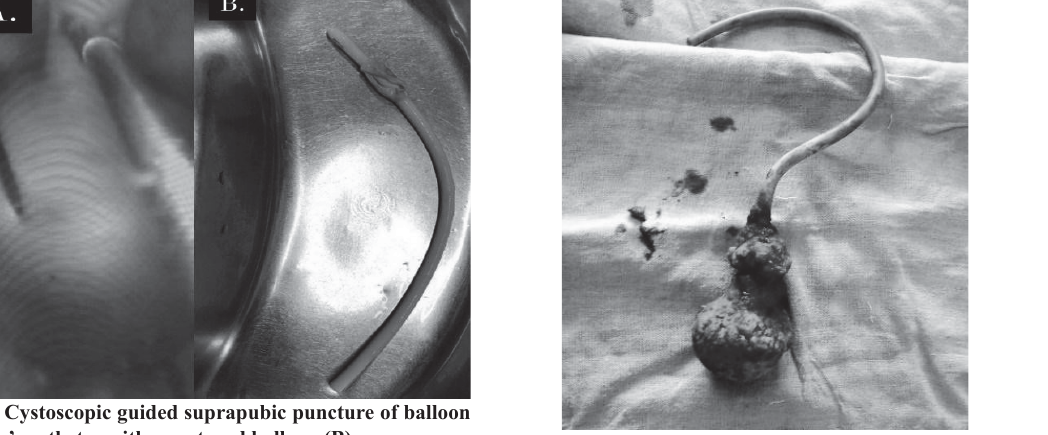
Figure 2. Intact removal of calculus formed over foley’s balloon.